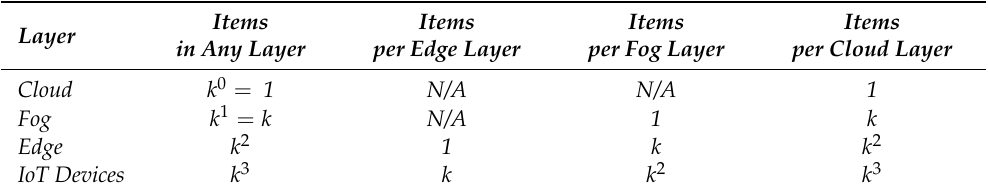
Table 2. Number of devices for each layer in a hub and spoke interfog scenario within the MEC framework proposed.